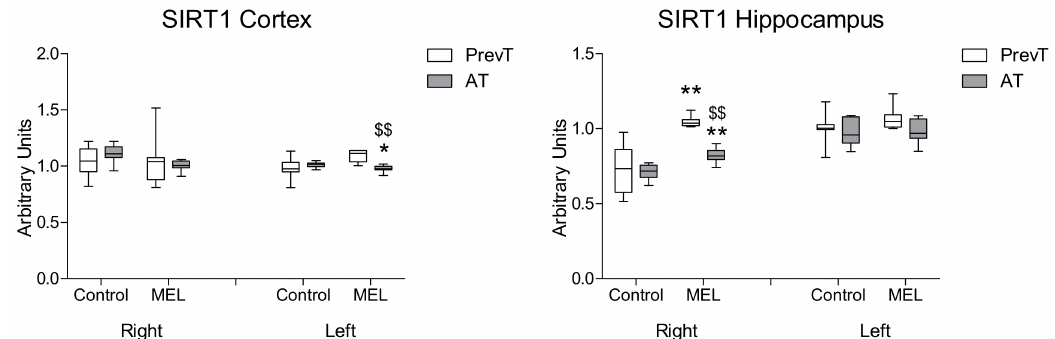
Figure 7. Right and left cortical and hippocampal mRNA expression of SIRT1 in 18-month-old rats in control (non-treated) conditions, after treatment with a daily dose of melatonin (10 mg/kg b.w.) from 24 h before until 7 days after surgery (PrevT), and treated only after surgery during 7 days (AT). Each value represents the median, interquartile and full range of five determinations performed in duplicate. * p < 0.05 with respect to the values obtained in the control group; ** p < 0.01 with respect to the values obtained in the control group; $$ p < 0.01 with respect to the values obtained in the PrevT